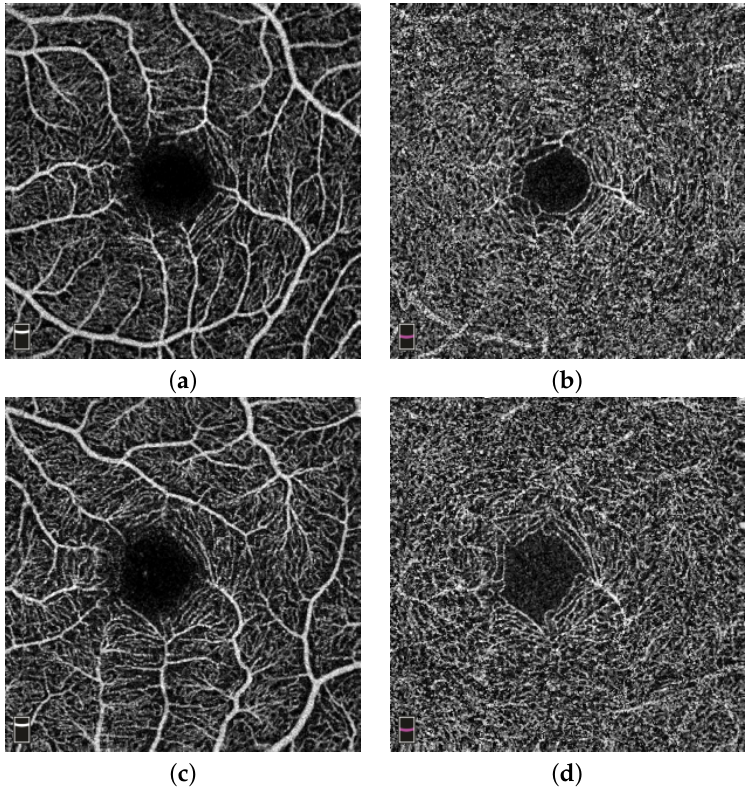
Figure 3. Example of microvasculature density. ( a , b ) Microvasculature density in the superficial (ILM-IPL) and deep layer (IPL-OPL) of the retina in a stroke subject; ( c , d ) vessel density in the superficial (ILM-IPL) and deep layer (IPL-OPL) of the retina in a control